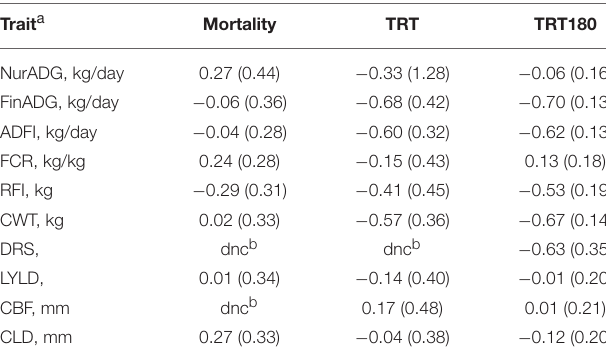
TABLE 4 | Estimates of genetic correlations (SE) of mortality and number of treatments with production traits. Trait a Mortality TRT